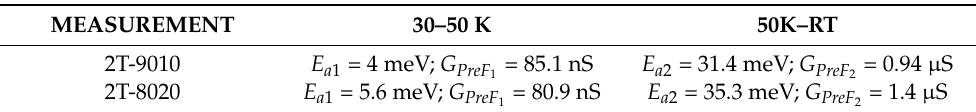
Table 3. Calculated values for E a 1 , E a 2 , G PreF according to Equation